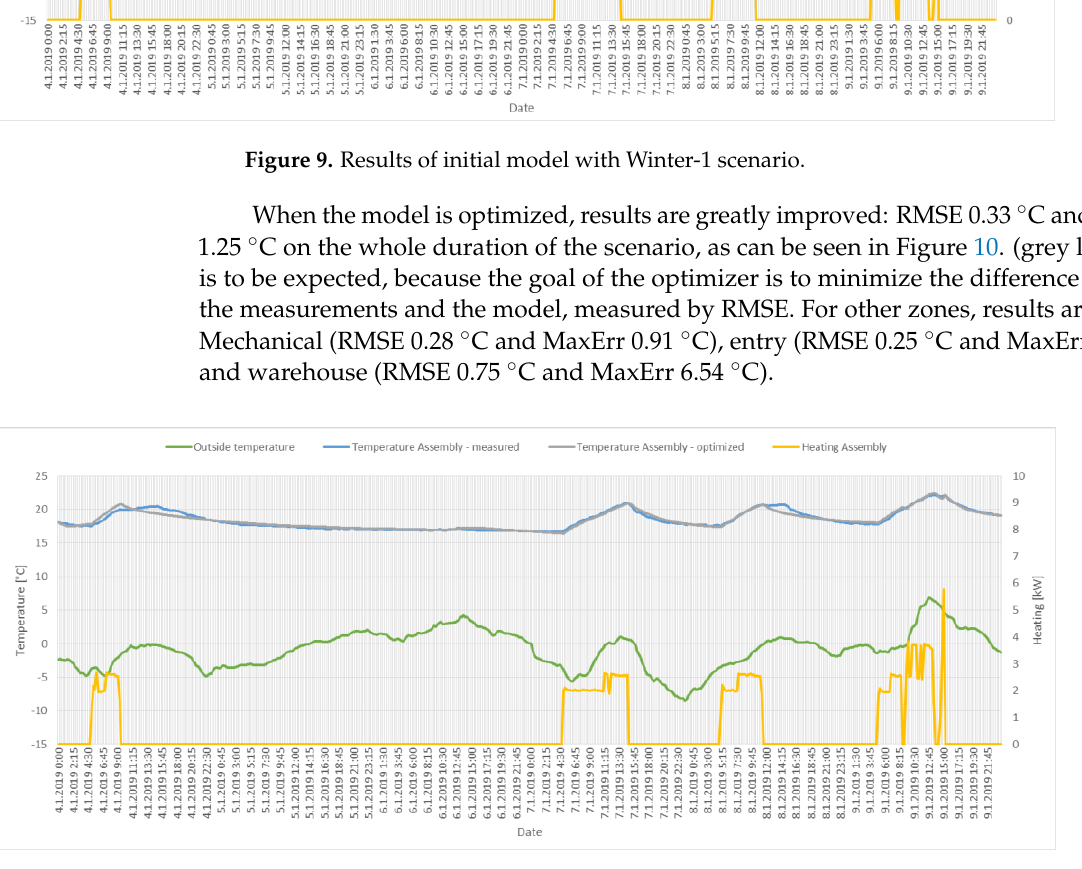
Figure 10. Results of optimized model with Winter-1 scenario.